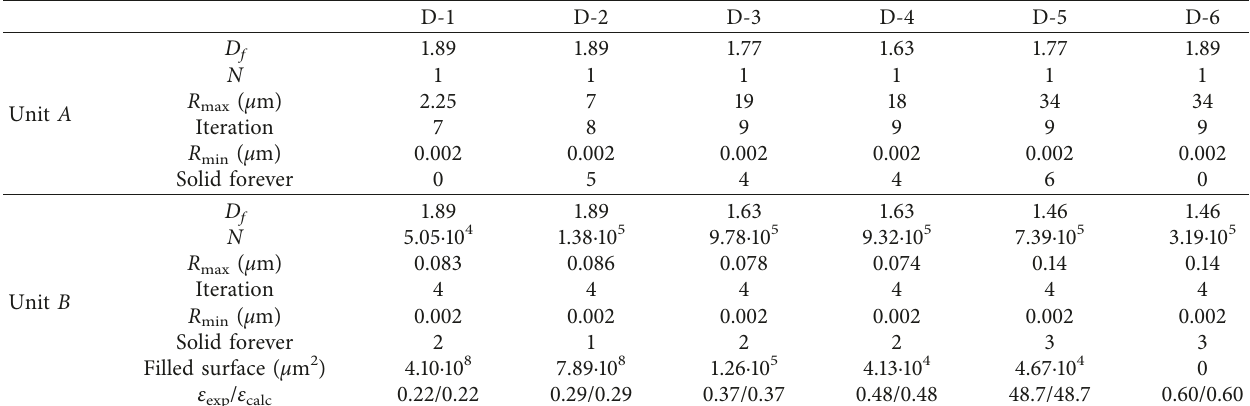
Table 4: IFU input data to models D-1, D-2, D-3, D-4, D-5, and D-6. The fractal dimension ( D f ), the maximum ( R max ) and minimum rays ( R min ), the number of iterations, the number of solid forever squares for each base unit (the Sierpinski carpet), the number of B base units ( n B ), the filled surface (FS) used to build the IFU, and comparison between experimental ( ε exp ) and predicted pore volume fractions ( ε IFU